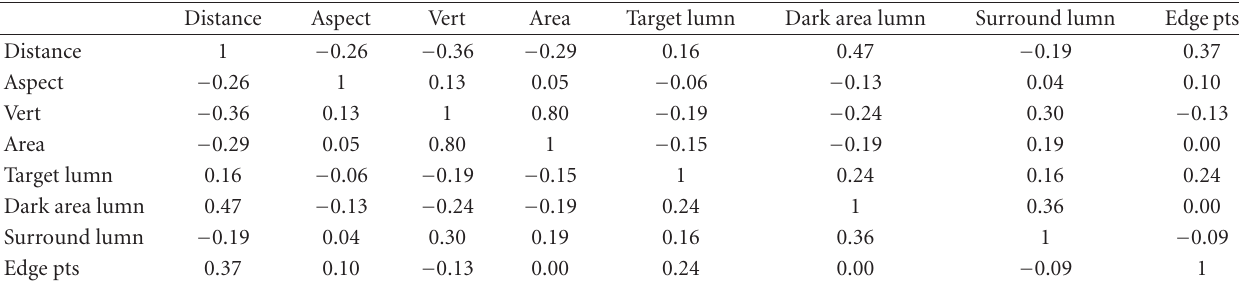
Table 11: MiniTab analysis of Boolean vector